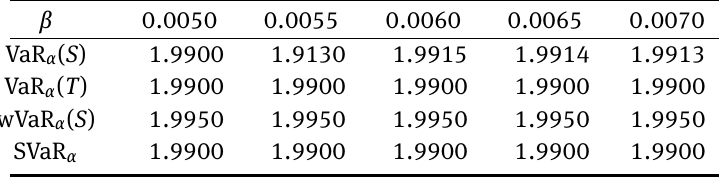
Table 2: Summarized results for Example